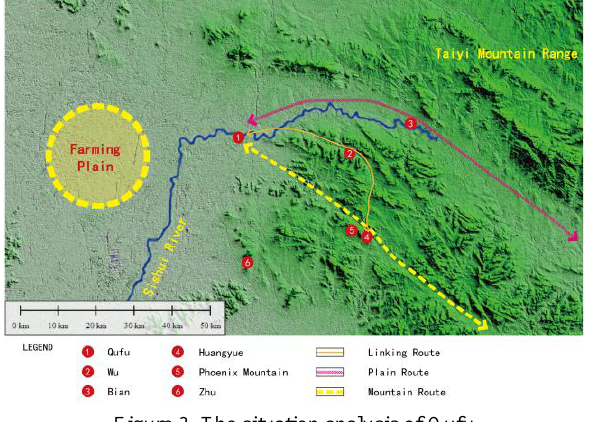
Figure 3. The situation analysis of Qufu Three defense cities, with disparate strategic significance, crowded together and depended on each other: Wu and Huangyue were military stronghold with difficult terrain and function, and Bian was an extremely important forward post (Fig. 3). Wu was located on a platform surrounded by Longwantao set of reservoir, facing water three sides and no direct foreign traffic, which was easy to keep and difficult to attack. In macro view, the city could be cooperative engagement with other cities or serve as final fortress, as it was situated in the middle of Qufu and other two cities (Fig. 4-6).